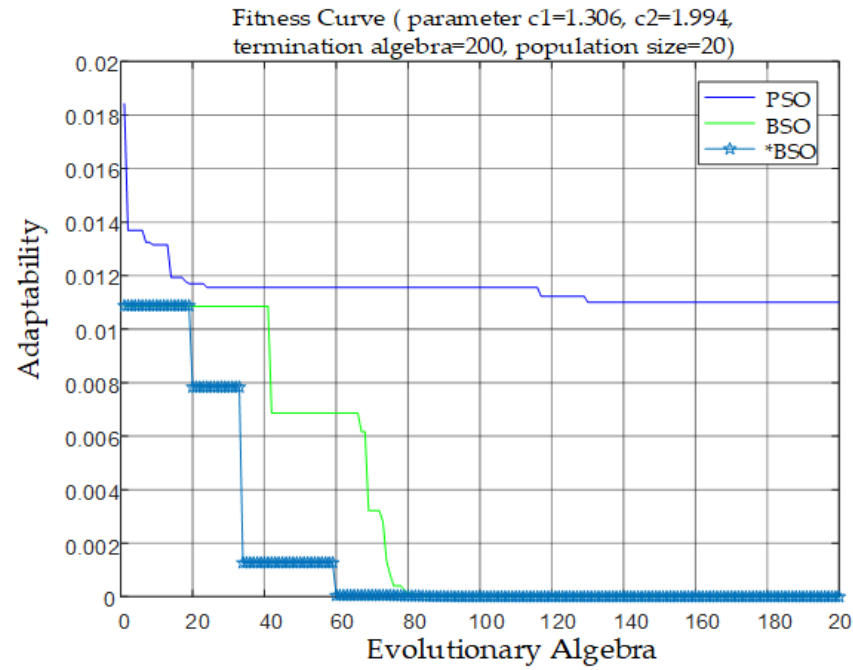
Figure 2. Comparison of fitness curves.